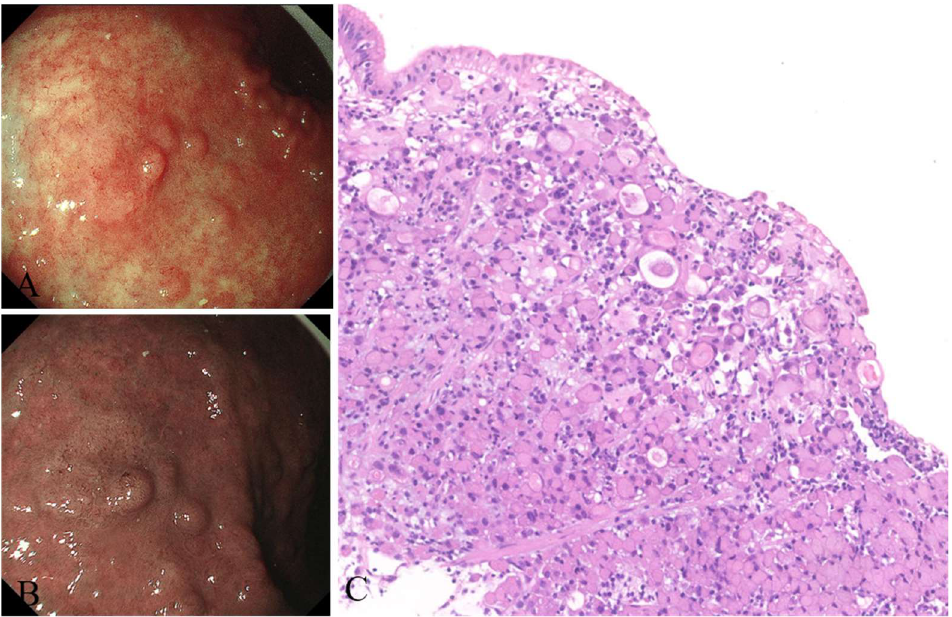
Figure 7. Signet-ring-cell carcinoma arising from AMAG. ( A ) White light and ( B ) NBI showed a depressed lesion in the corpus, and ( C ) pathology revealed signet-ring-cell carcinoma (HE stain, ( C ) ×10).